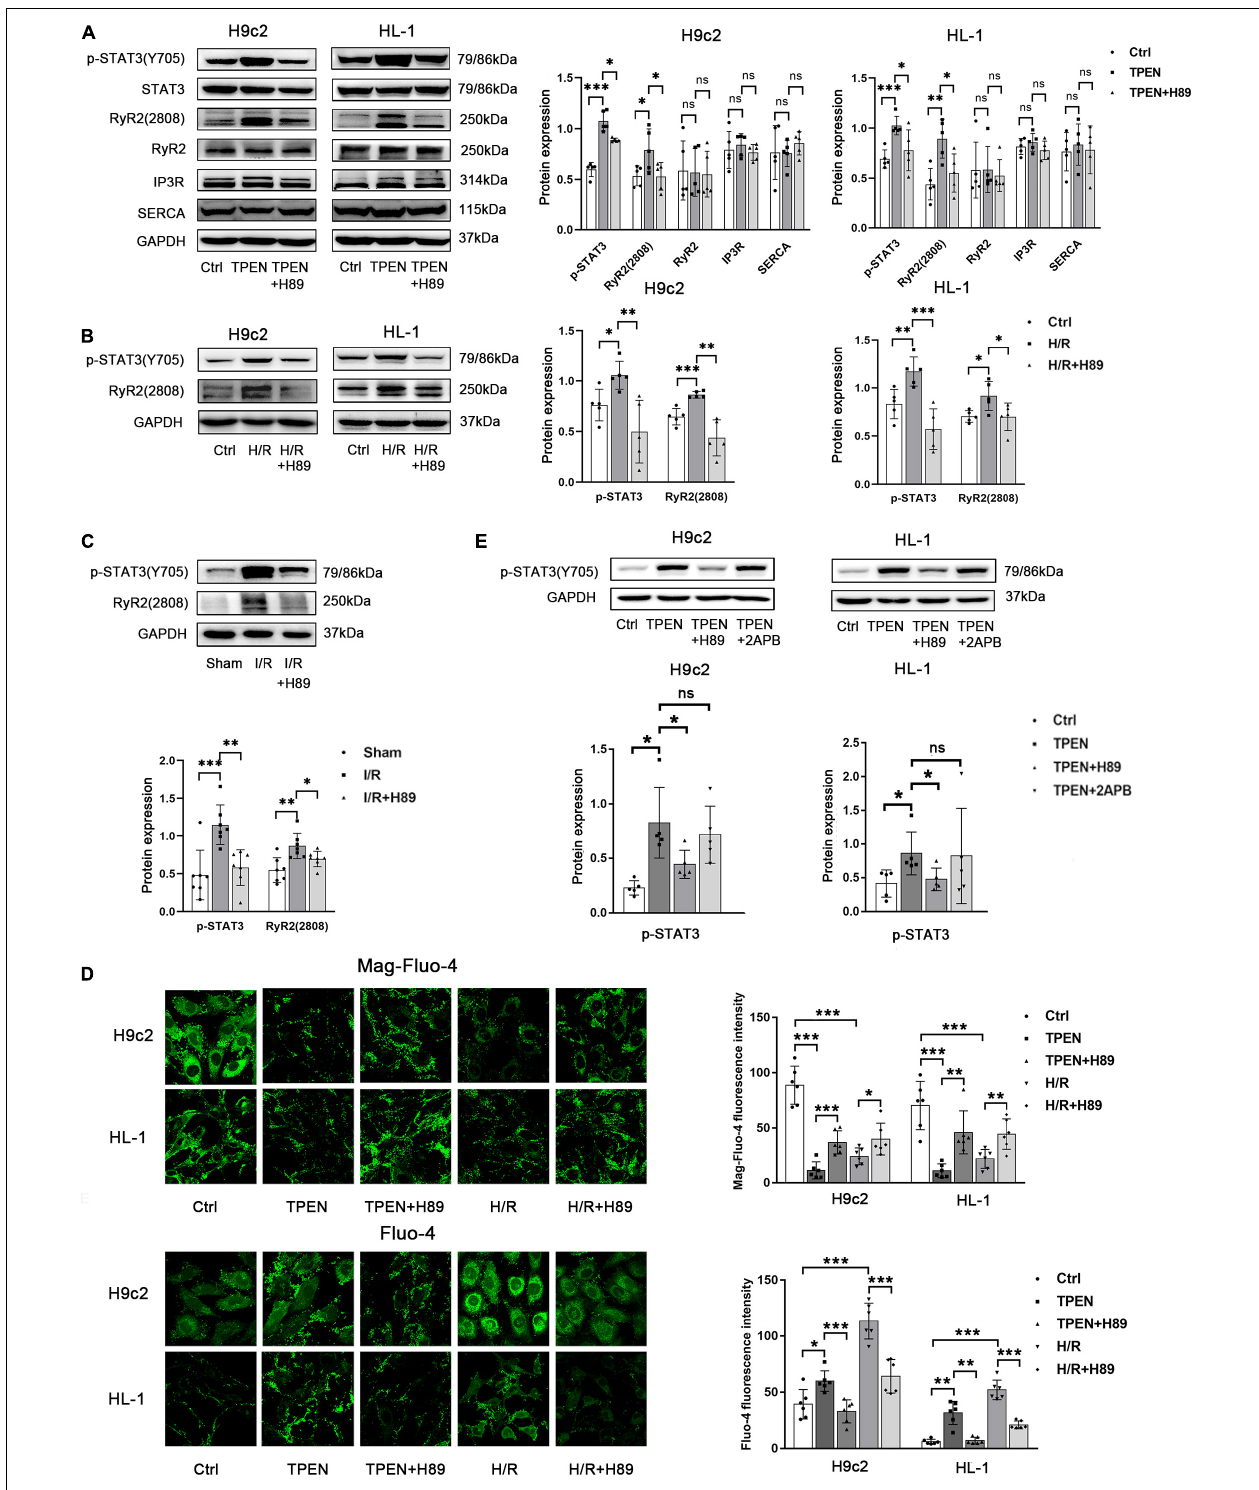
FIGURE 3 | Zinc deficiency activates Ca 2 + leak from ER via RyR2. (A,B) H89 (PKA inhibitor,10 µ M, n = 5) was applied 2 h before exposure to TPEN for 2 h or 30 min before the onset of reoxygenation. (C) Mouse hearts were ischemic for 30 min and then reperfused for 30 min. H89 (10 mg/kg) was injected 5 min before reperfusion and continued for 30 min through the tail vein ( n = 7). (D) H89 (10 µ M, n = 6) was applied 2 h before exposure to TPEN for 2 h or 30 min before the onset of reoxygenation and labeled with Mag-fluo-4 (5 µ M, n = 6) and Fluo-4 (5 µ M, n = 6), respectively. (E) H89 (10 µ M, n = 5) and 2APB (100 µ M, n = 5) were applied 2 h before exposure to TPEN for 2 h. ∗ p < 0.05, ∗∗ p < 0.01, and ∗∗∗ p < 0.001. ns, no significant difference P > 0.05.